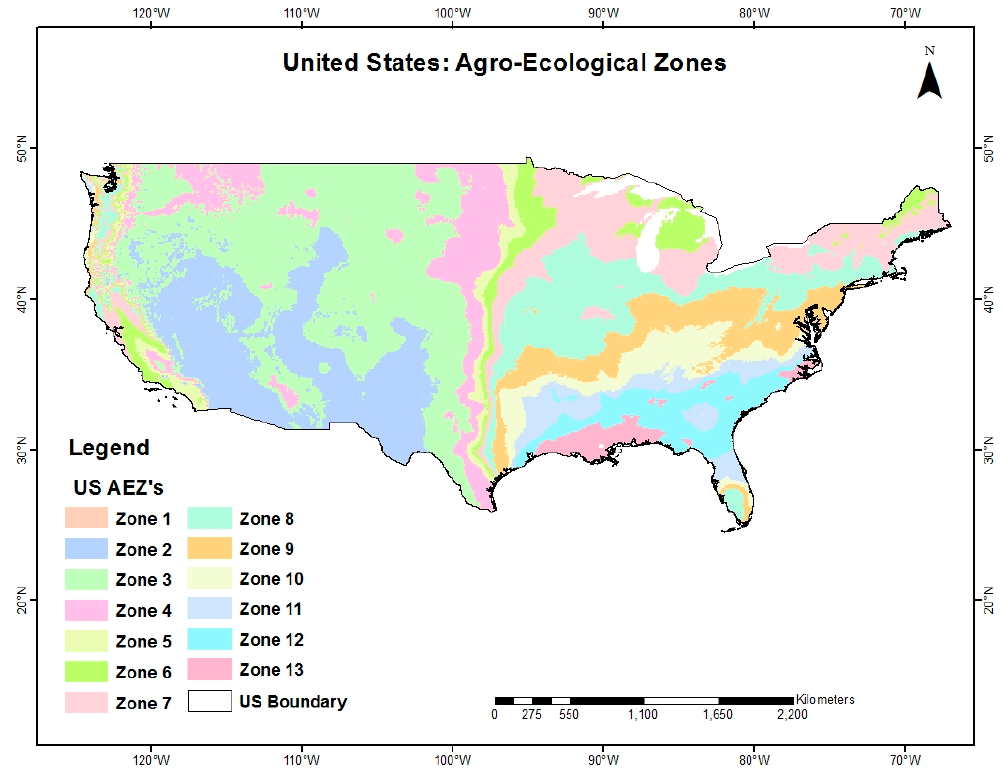
Figure 3. The distribution of Agro-ecological zones in the United States.